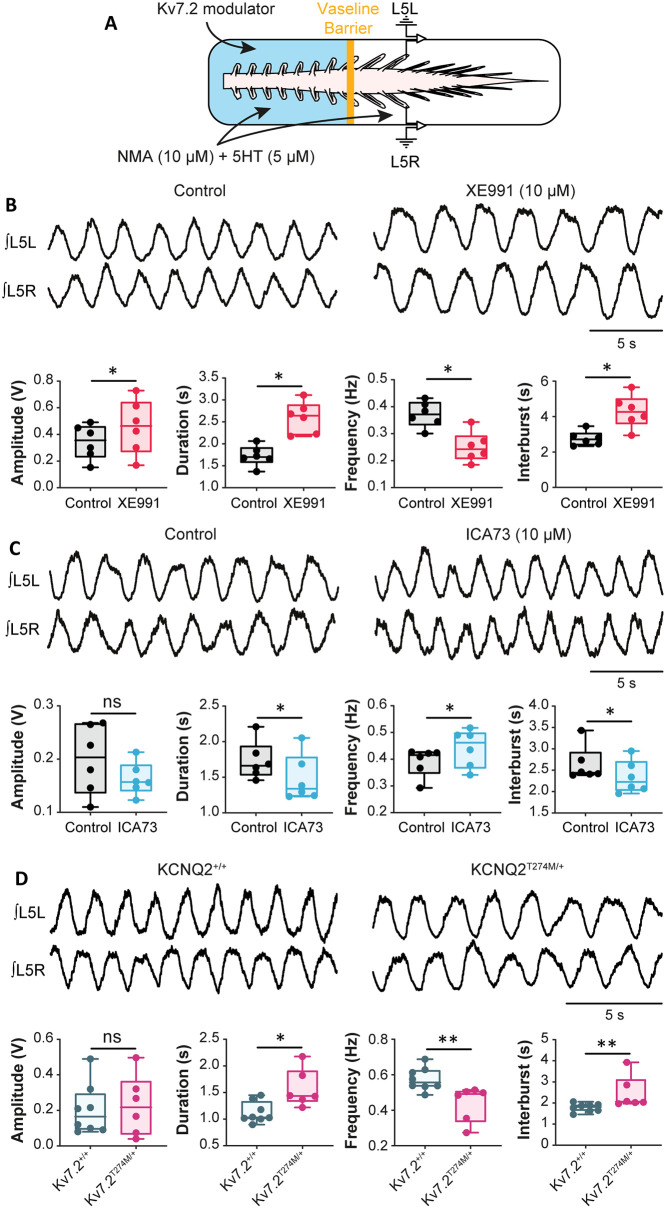
IM mediated by Kv7.2-containing channels modulates the locomotor cycle at the level of the CPG.(A) Experimental setup. (B,C) Ventral-root recordings of NMA/5-HT–induced rhythmic activity generated before and after adding XE991 (10 μM, n = 5 spinal cords) (B) or ICA73 (10 μM, n = 6 spinal cords) (C) to rostral lumbar segments. Below traces, boxplot quantification of locomotor burst parameters. *P < 0.05, comparing data before and after the abovementioned drugs; Wilcoxon paired test. (D) Ventral-root recordings of NMA/5-HT–induced rhythmic activity generated in wild-type and Kv7.2Thr274Met/+ mice. Below traces, boxplot quantification of locomotor burst parameters. *P < 0.05, **P < 0.01, comparing wild-type versus mutant; Mann–Whitney test. Underlying numerical values can be found in the S1 Data. CPG, central pattern generator; ICA73, N-(2-chloro-5-pyrimidinyl)-3,4-diflurobenzamide; NMA, N-methyl-DL aspartate; ns, not significant; XE991, 10,10-bis(4-pyridinylmethyl)-9(10H)-anthracenone dihydrochloride; 5-HT, 5-hydroxytryptamine.